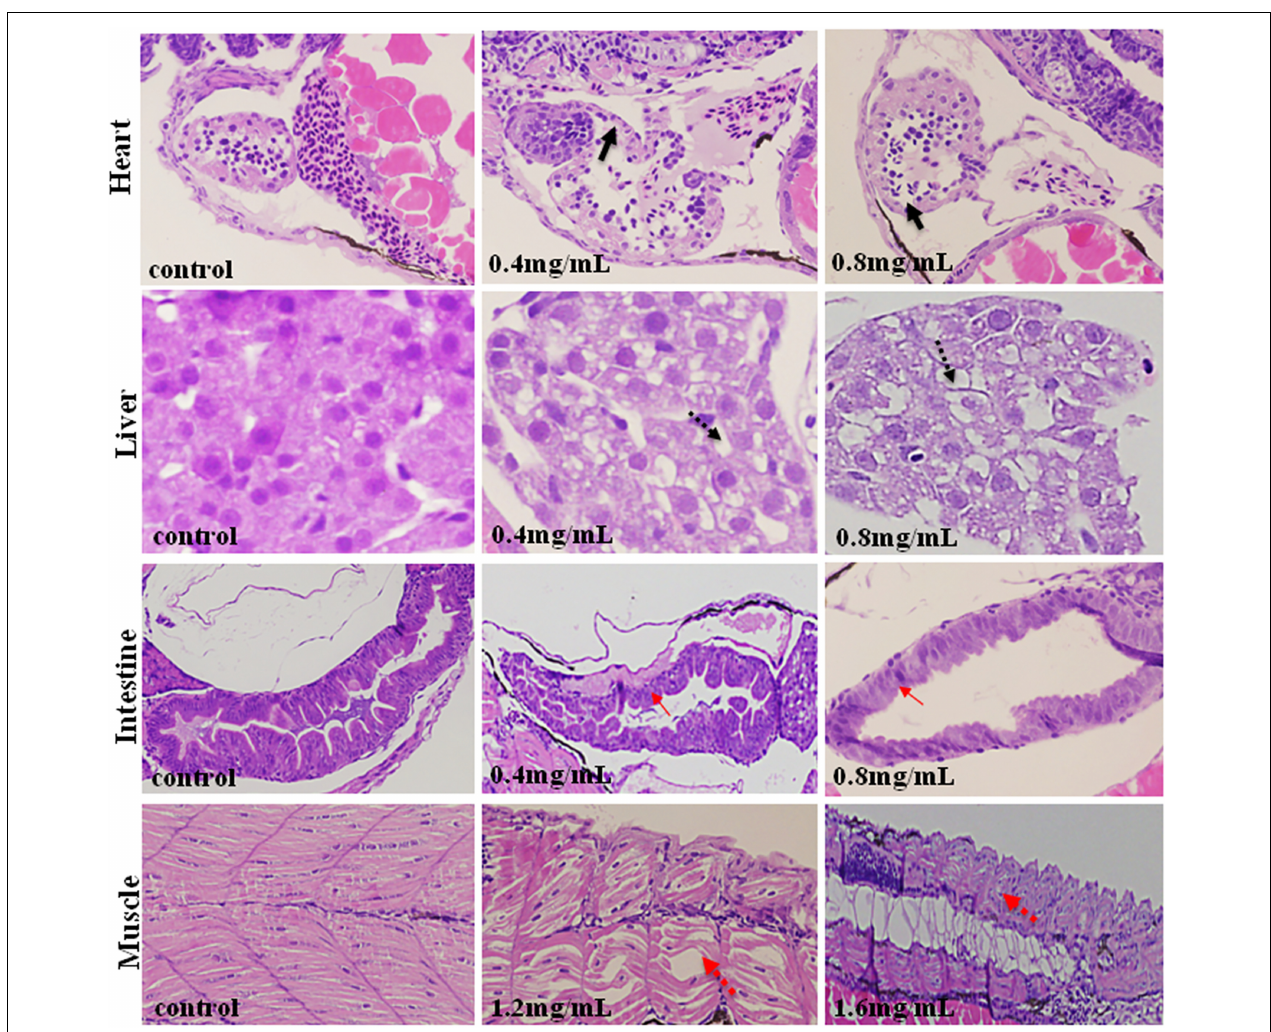
FIGURE 4 | Histopathological changes in the hearts, livers, intestines and muscles of zebrafish larvae exposed to XAP at 120 hpe. A thinner heart wall is indicated by a solid black arrow. Loose hepatocytes are indicated by a dotted black arrow. Frayed gut villi is indicated by a solid red arrow. Muscle atrophy is indicated by a dotted red